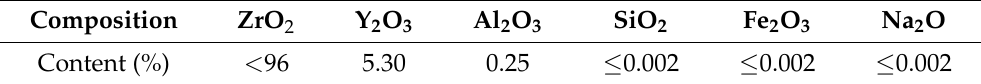
Table 1. Compositions of the dental zirconia ceramics used for the experiments.